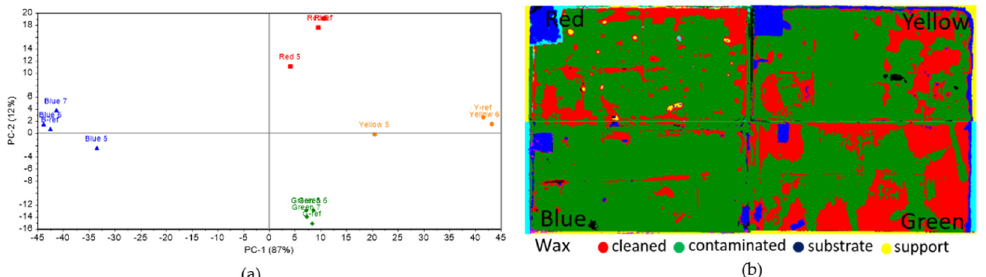
Figure 10 . Colorimetric and hyperspectral evaluation of BW decomposition by fungal lipase. ( a ) Score plot of the first 2 PCs, based on colorimetry data; ( b ) SAM images based on hyperspectral data.